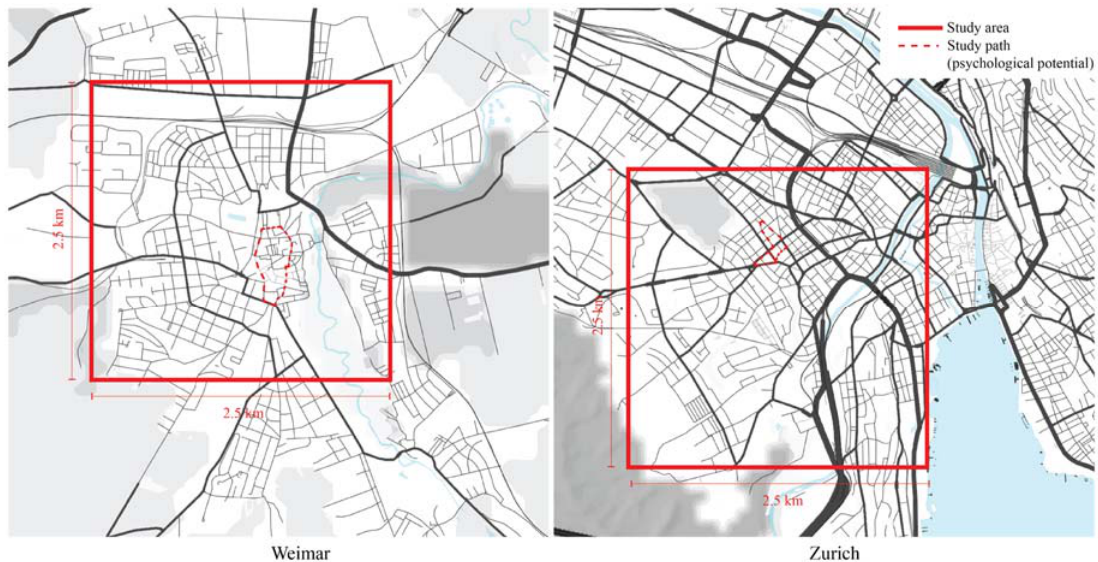
Figure 1. Case study areas in two cities—Weimar, Germany and Zürich, Switzerland. Both case studies comprise 6.25 km 2 and contain the path used to study psychological potential of urban form. (Data source: OpenStreetMaps.org and Mapbox.com).